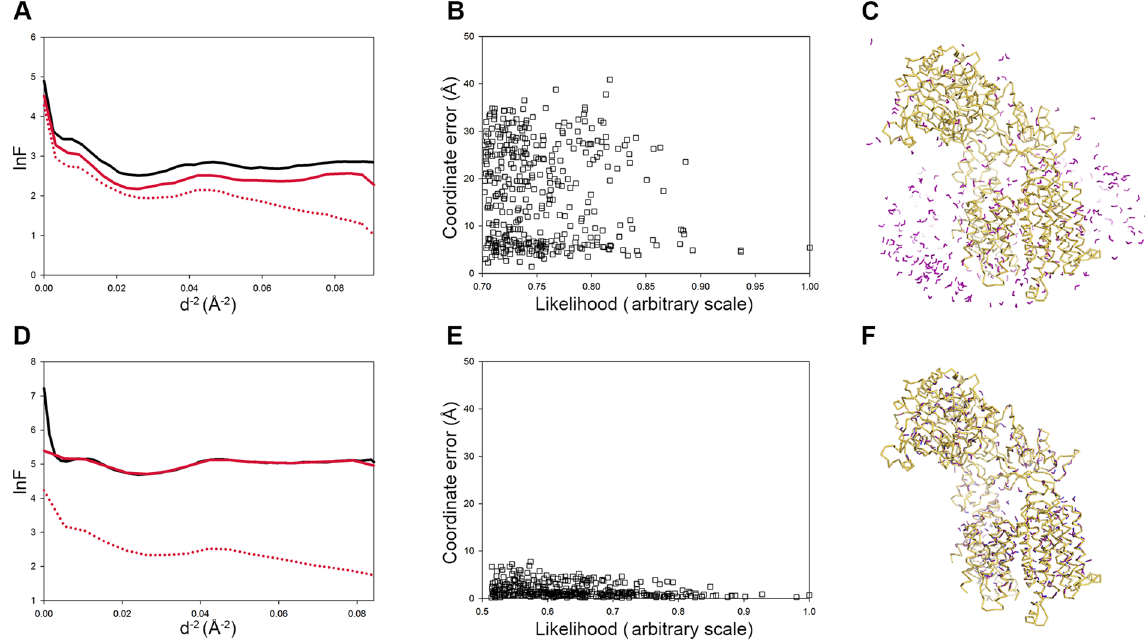
Figure 5. Accuracy evaluation of the map simulations of Buccaneer and EMBuilder. The lnF vs d − 2 plots of the working map, original reference map and simulated reference map are shown as a solid black line, dotted red line and solid red line, respectively (panels A and D). The C α distances between the structures deposited in PDB and the C α finding are presented in panels B and E, respectively. The structures deposited in PDB and the C α finding are shown as yellow ribbons and purple sticks, respectively (panels C and